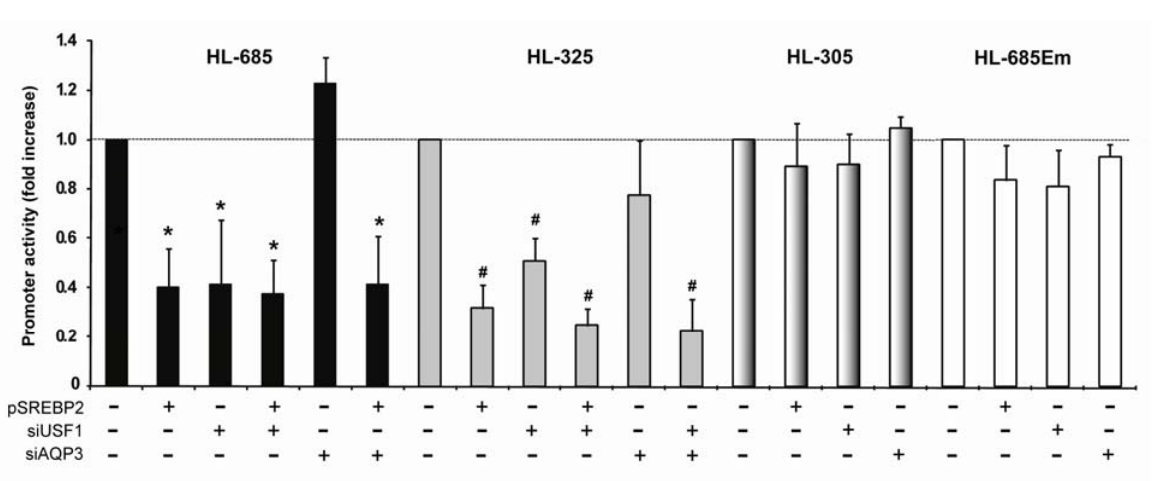
Figure 6. The effect of SREBP2 and USF1 is mediated by the -310 E-box of the HL gene. HepG2 cells were transfected with the indicated HL-promoter constructs without (-) or with (+) 6 ng pSREBP2 and/or 100 ng siUSF1 or siAQP3. Luciferase activity was determined after 48 h; data are expressed as fold increase relative to the transfection with the respective HL-promoter construct (n = 3–11; *: P < 0.05 vs. control of HL-685, # : P < 0.05 vs. control of